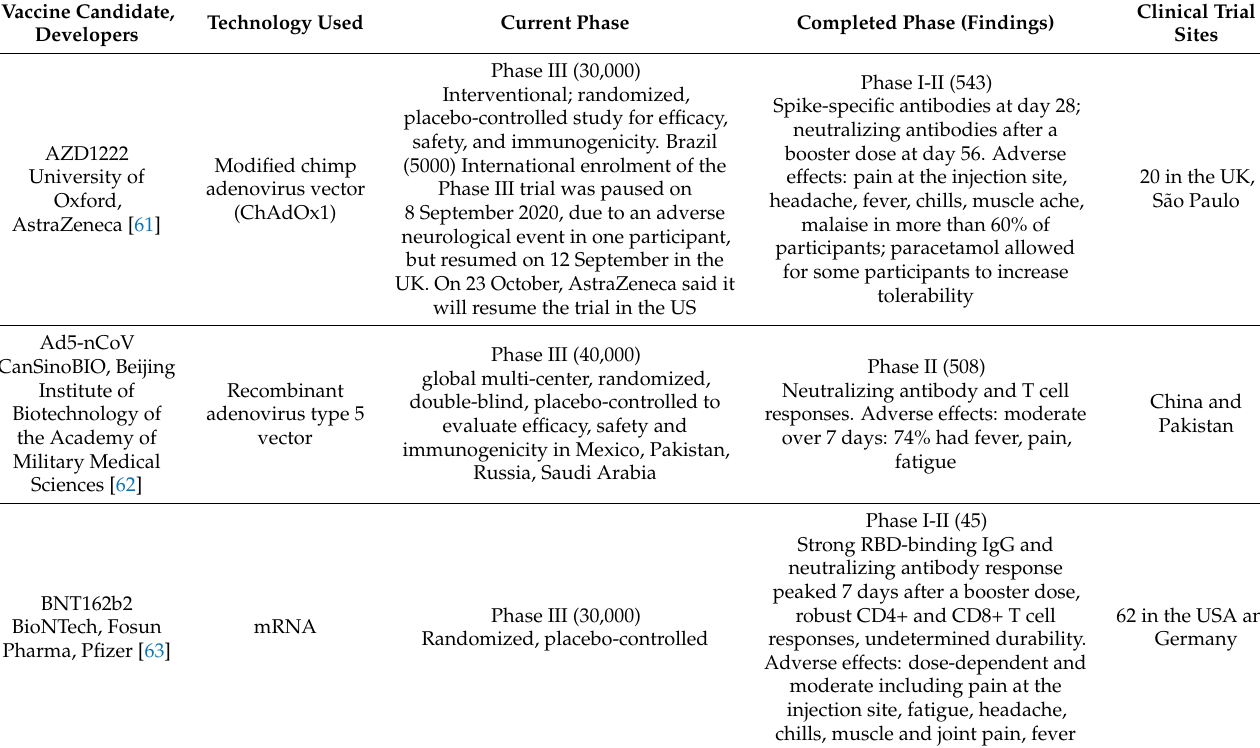
Table 1. Vaccinations currently in phase III of clinical trials for the SARS-CoV-2 virus. Vaccine Candidate,